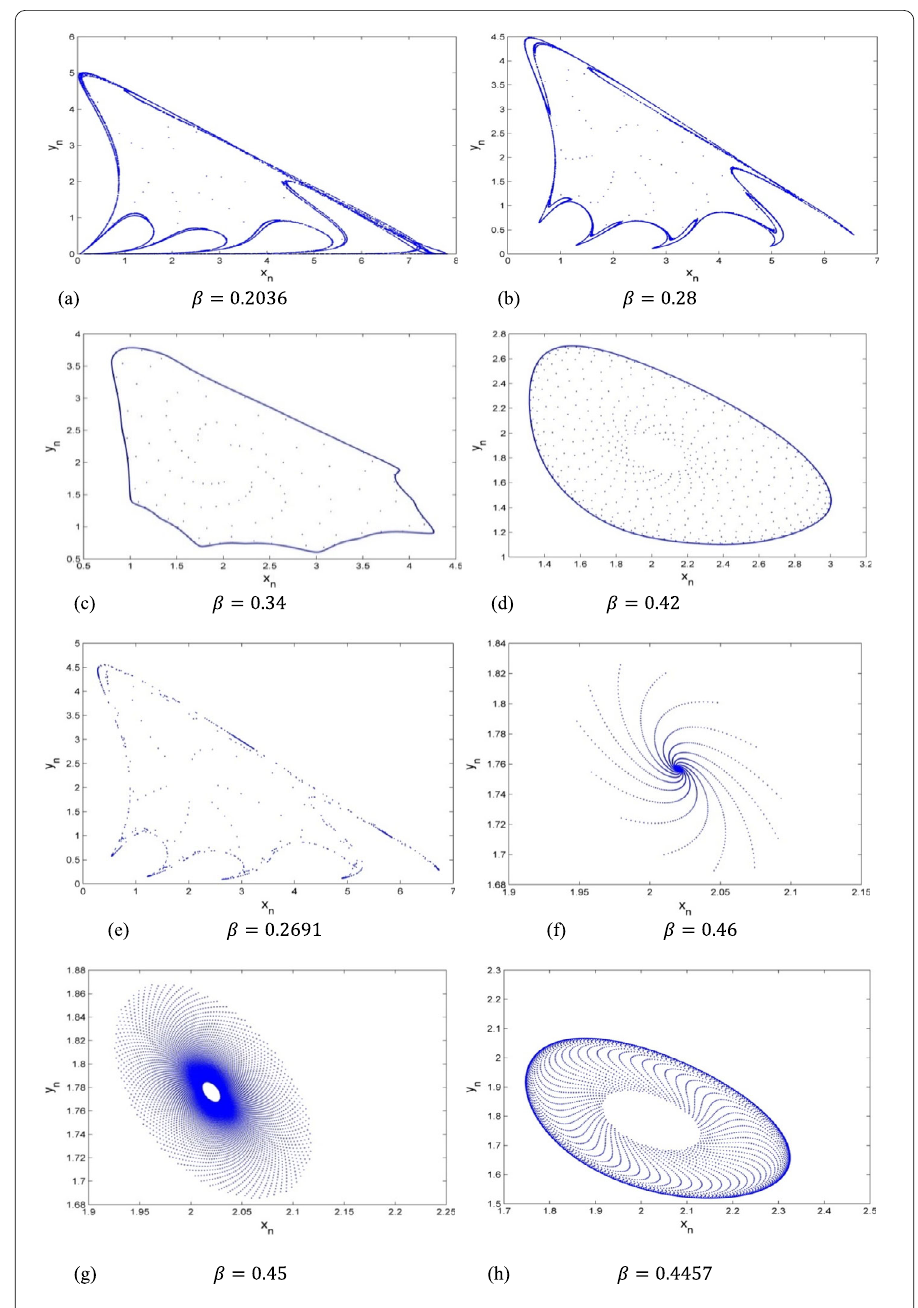
Figure 5 Phase portraits of system (4) for different values of bifurcation parameter β